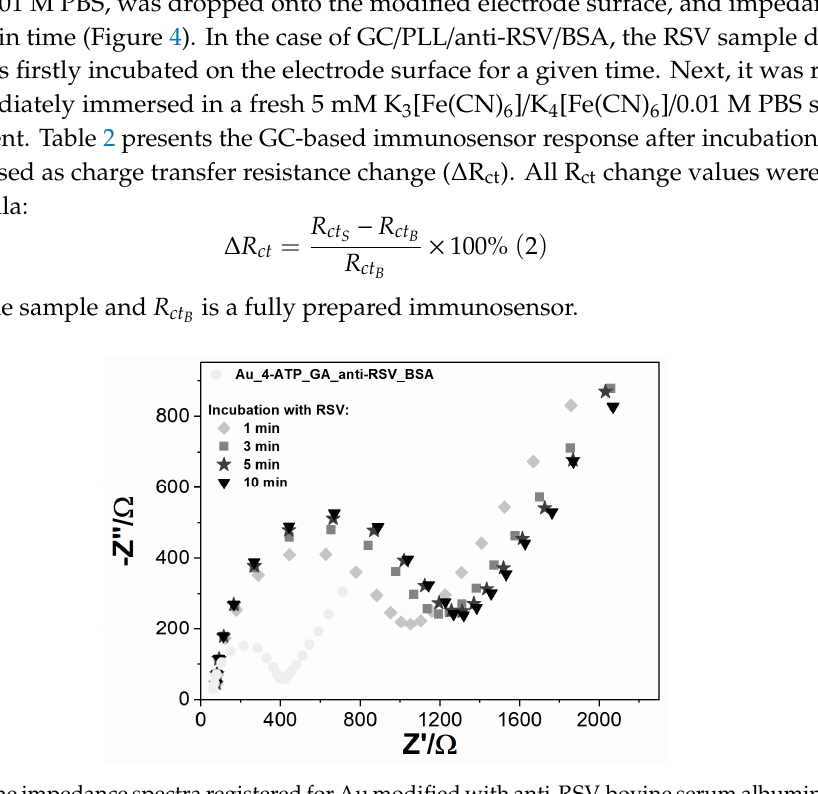
Figure 4. The impedance spectra registered for Au modified with anti-RSV-bovine serum albumin (BSA), incubated for di ff erent periods (1–10 min) with RSV, registered in 5 mM K 3 [Fe(CN) 6 ] / K 4 [Fe(CN) 6 ] / 0.01 M PBS.